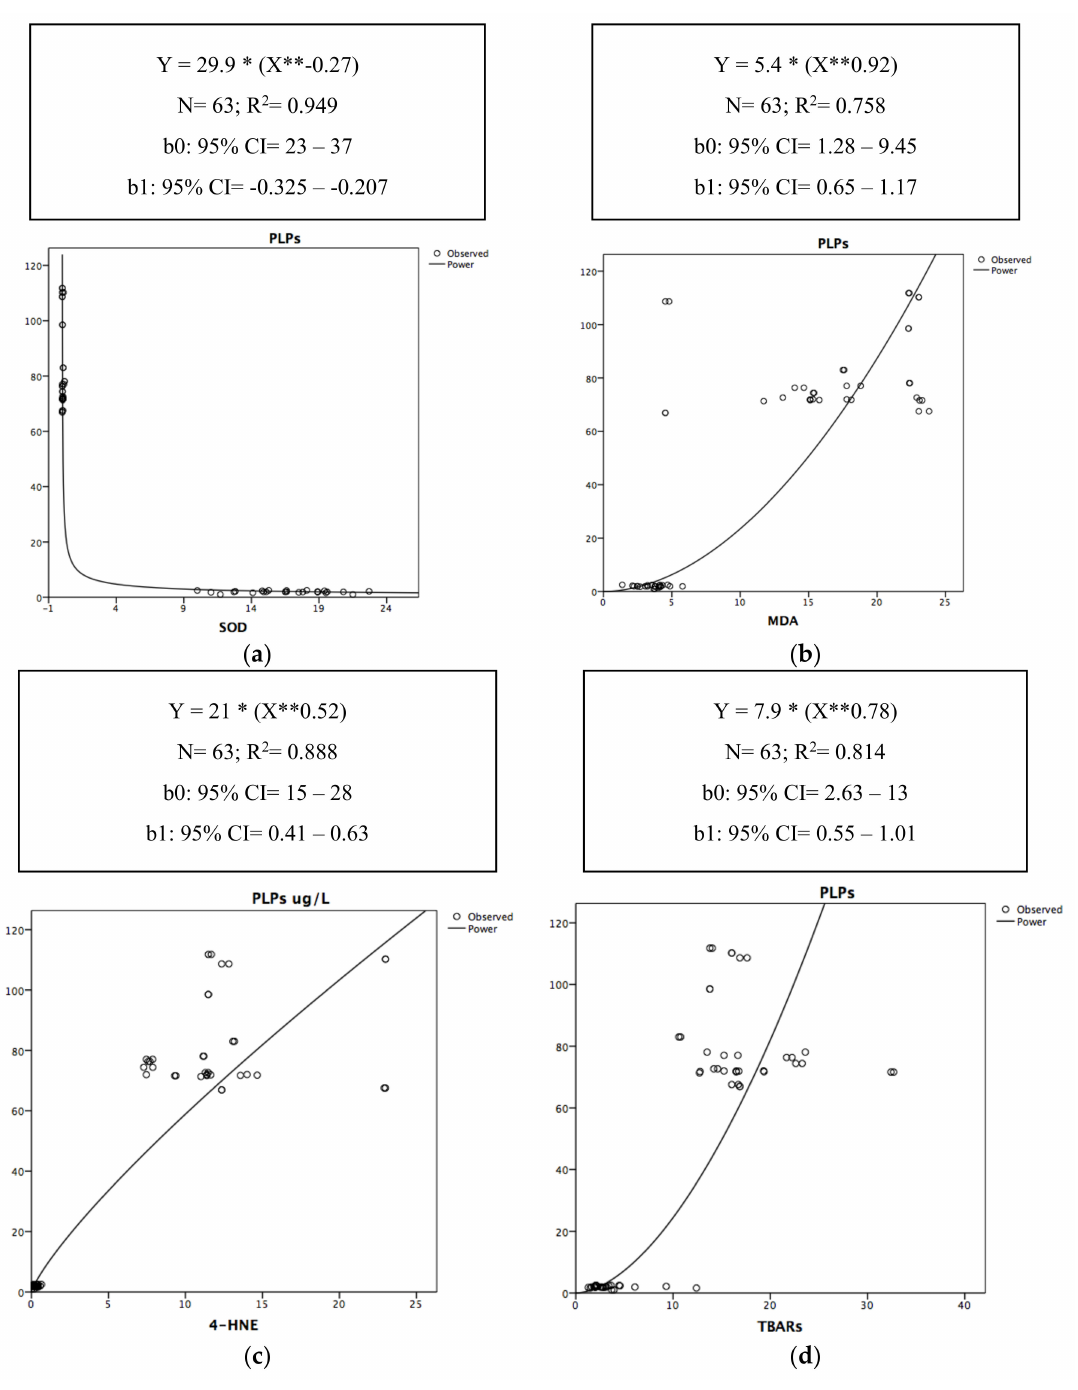
Figure 1. ( a – d ) Non-linear scatter diagrams of determination between PLPs and SOD ( a ), MDA ( b ), 4-HNE ( c ), TBARs ( d ). R 2 = the value of R 2 (in terms of percentage) expresses the percentage of the variability of the outcome (PLPs) that can be explained by the predictor. *: the asterisk in the curve equation equals to the “ × ” sign of multiplication. **: the two asterisks in the curve equation equals to “X”